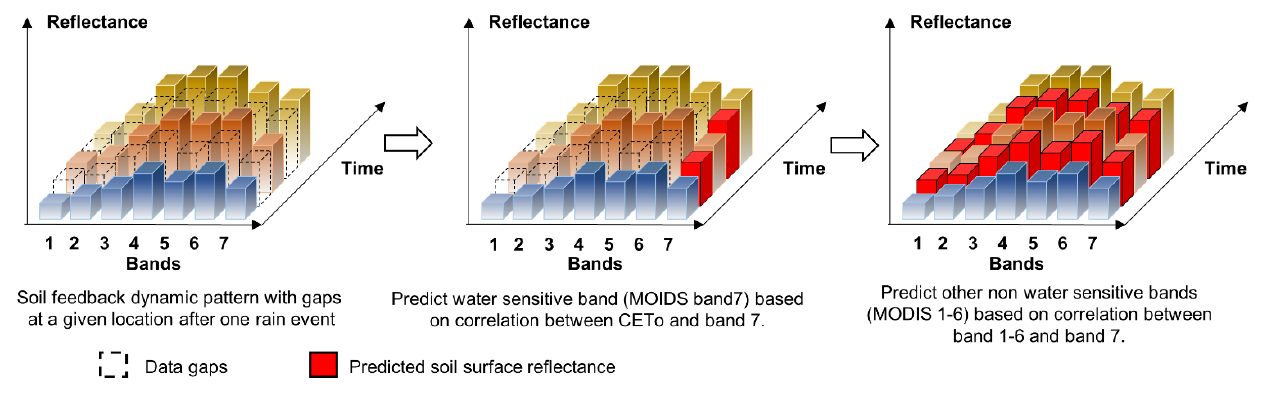
Figure 3. Basic concept for using two correlations to fill missing data gaps in a soil feedback pattern during one rain